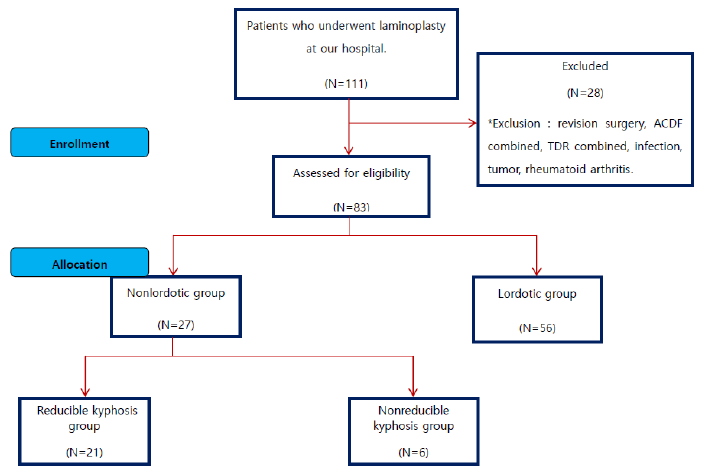
Figure 1. Flowchart of the study participants.